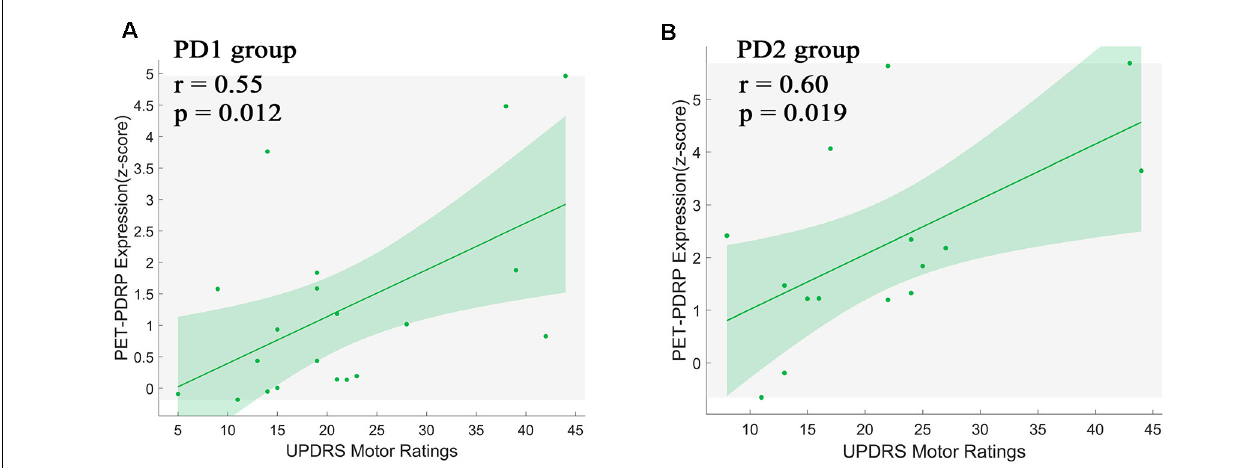
FIGURE 4 | PET-PDRP expressions in individual patients correlated with UPDRS motor ratings in the (A) original derivation subjects as well as in the (B) subsequent validation subjects. Shaded areas represent 95% confidence of intervals. UPDRS, Unified Parkinson’s Disease Rating